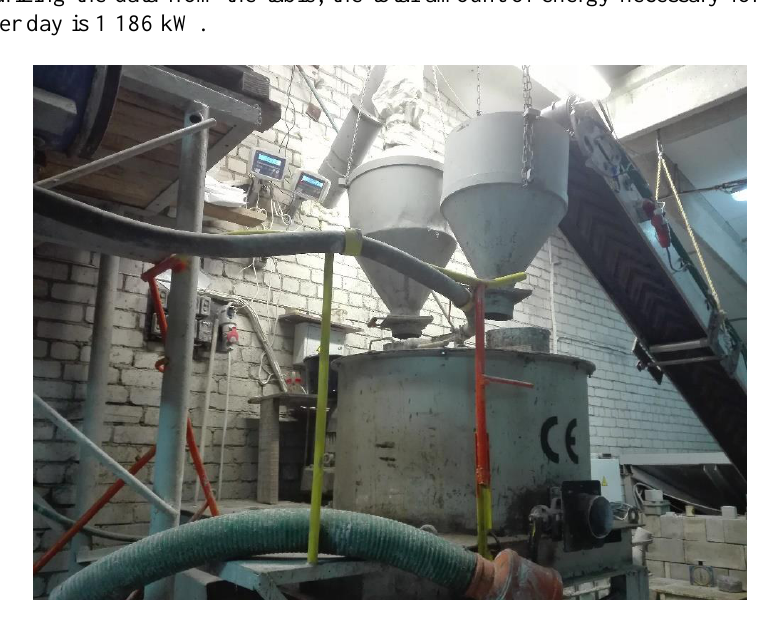
Fig. 1. Turbulence mixer with cavitation effect in the foam concrete plant (intensive mixing